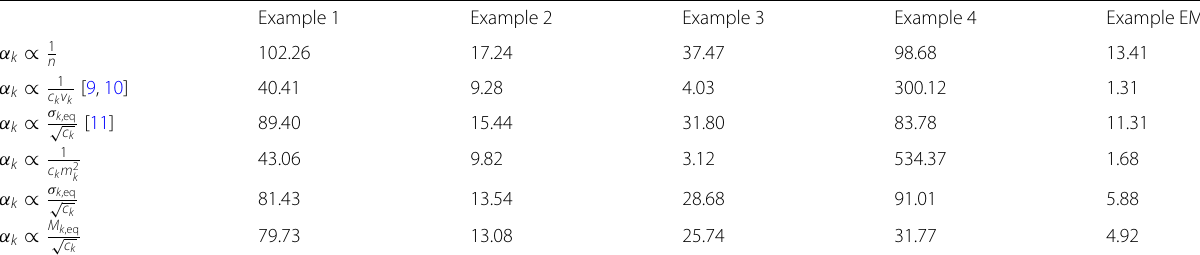
Table 4 Variance times cost (i.e., inefficiency, the smaller the better) for multi-sample estimator for the four examples in Appendix C and the environment map example ( × 10 − 3 ) for balance heuristic using equal count of samples, for the count inversely proportional to the variances of independent estimators [9] and[10], for the provably better, non-balance heuristic, estimator defined in [11], and for the three new estimators defined in this paper Example 1 Example 2 Example 3 Example 4